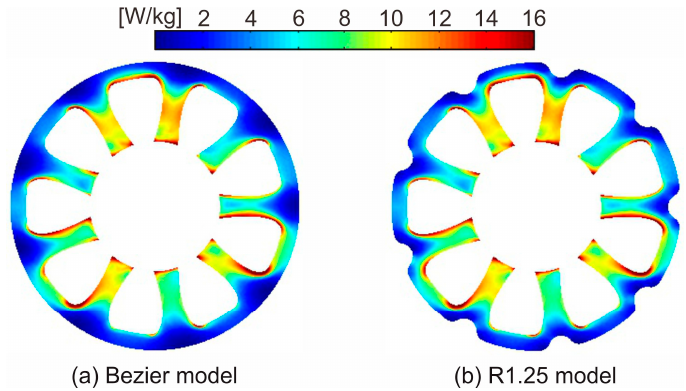
Figure 12. Core loss distribution of ( a ) the Bezier model and ( b ) R1.25 model.